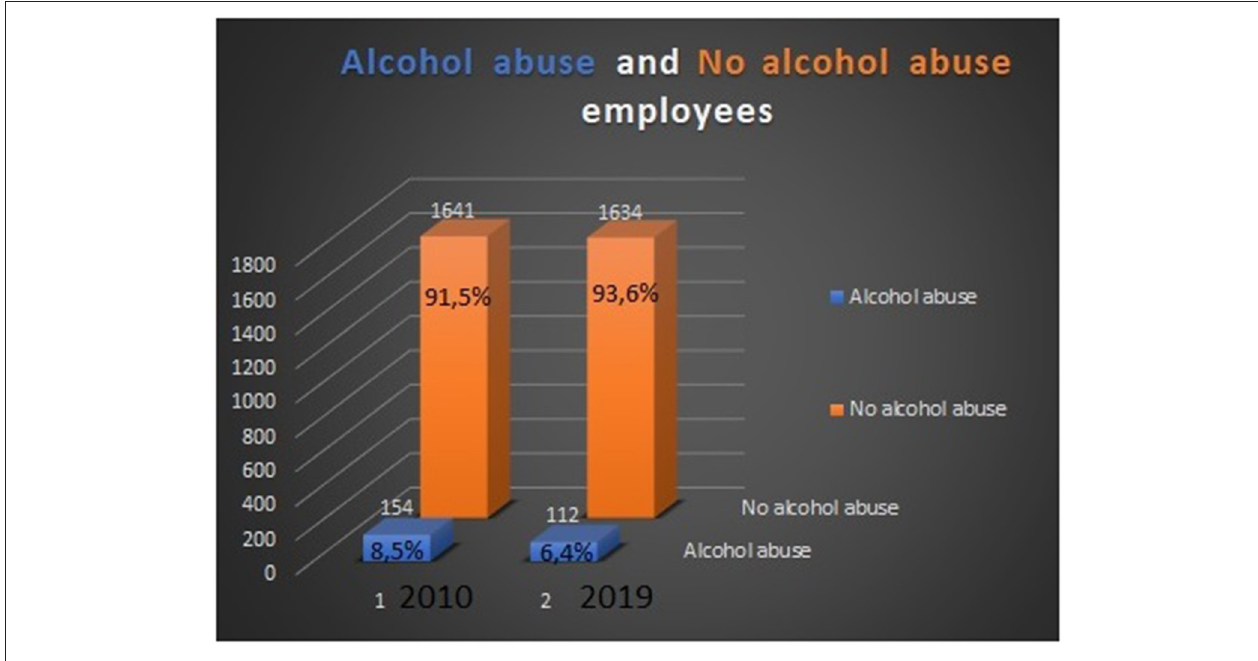
FIGURE 3 | Alcohol abuse vs. no-alcohol abuse employees in 2010 and 2019.